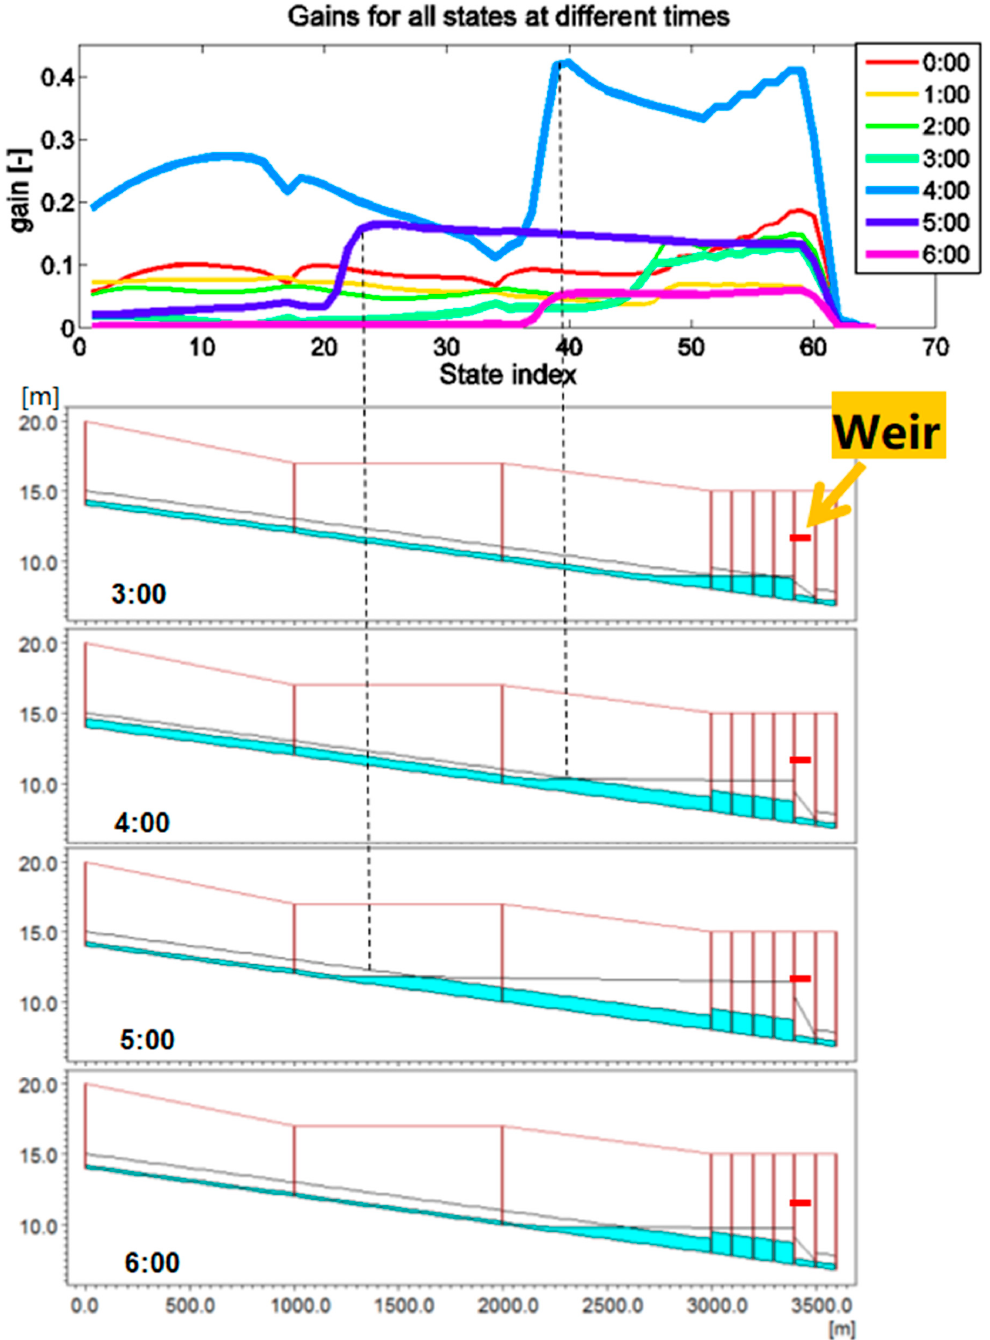
Figure 3. Kalman gain and water levels in the test setup. (Top) Gains for all water level grid points in the model for selected moments in time. (Lower four) Longitudinal profiles of the system showing water levels at four selected times for which the gain can be seen in the upper figure. The thin black lines show the hydraulic grade lines. The upper figure is aligned with the lower figure in such a way that each state variable is directly above the corresponding place in the longitudinal profiles.